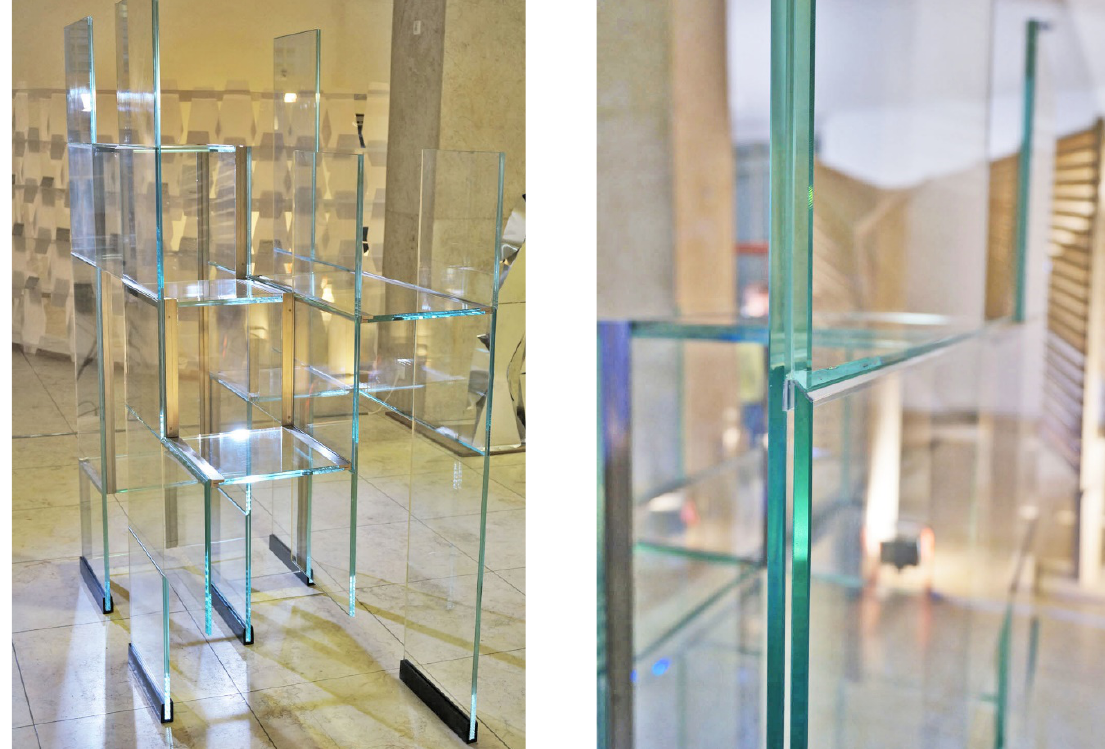
Fig. 9: Exhibition of the prototype at TU Munich, detail of the glass joining